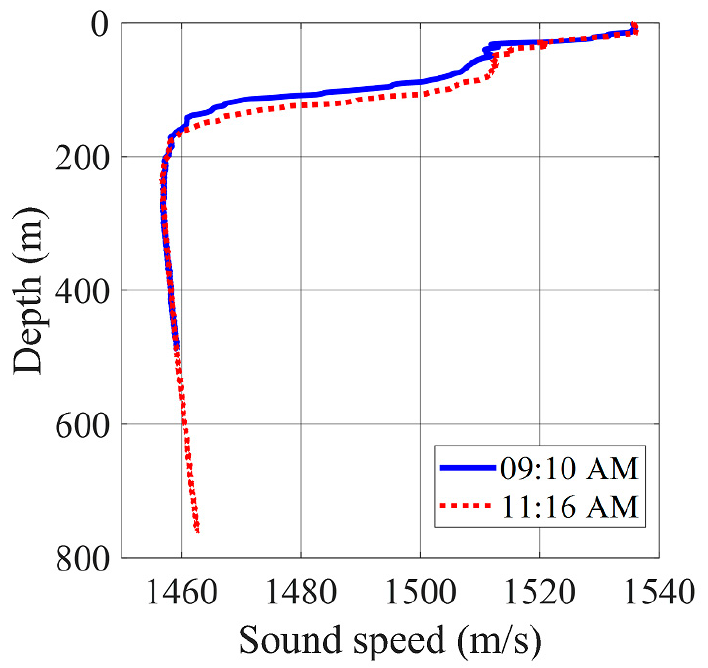
Figure 5. Sound speed profiles measured at the ship position at 9:10 AM and at 11:16 AM.